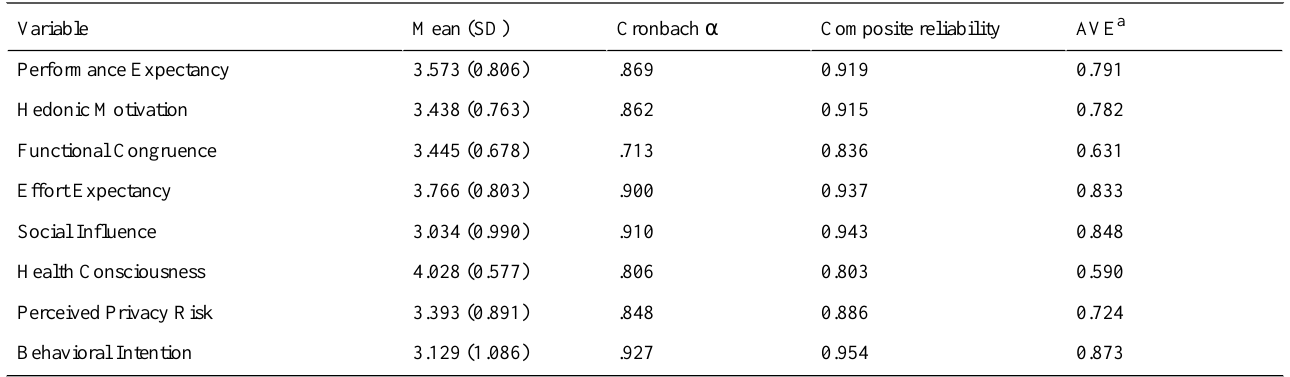
Table 5. Descriptive statistics, reliability statistics, and validity statistics.